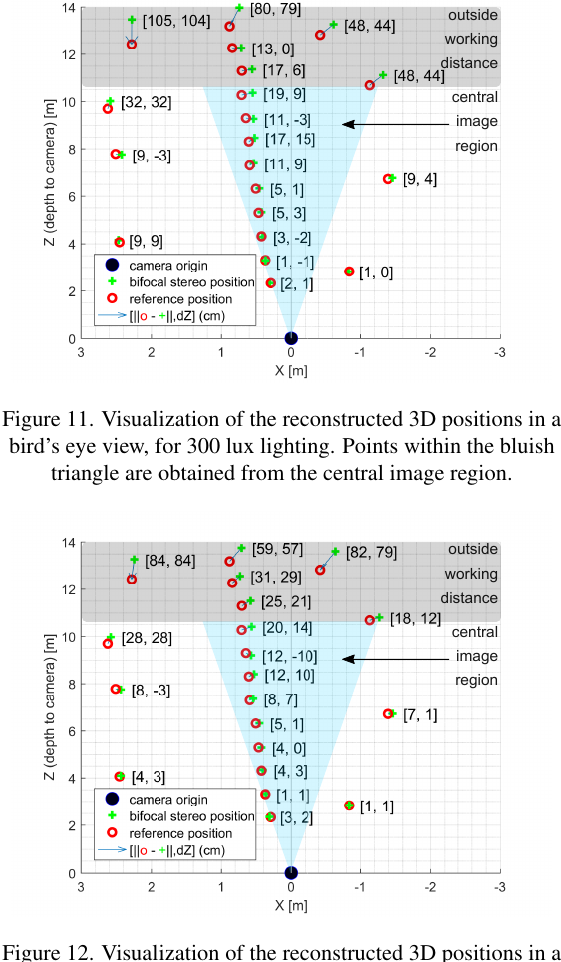
Figure 12. Visualization of the reconstructed 3D positions in a bird’s eye view, for 1000 lux lighting. Points within the bluish triangle are obtained from the central image